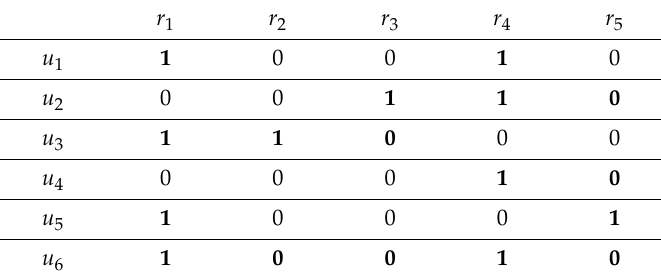
Table 16. Assignments in step 5.